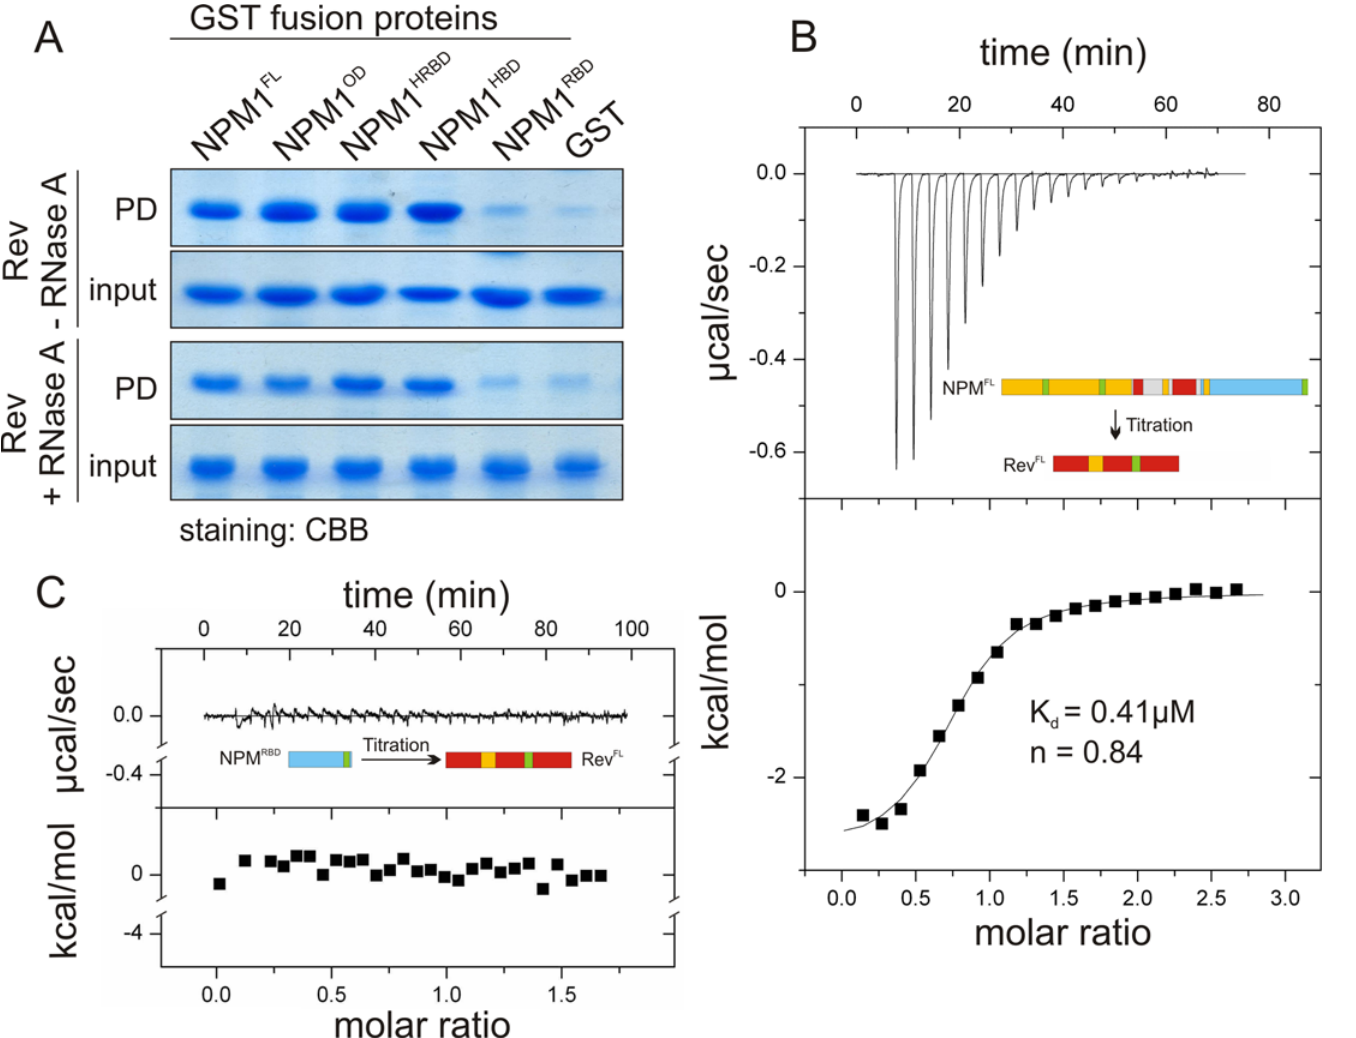
Fig 2. Direct NPM1 interaction with HIV-1 Rev. (A) Qualitative interaction analysis by GST pull-down assay and subsequent CBB staining. NPM1 FL, OD and HRBD, but not RBD, displayed a selective interaction with HIV-1 Rev (upper panel), which was also observed after an RNase A treatment (lower panel). (B) Quantitative interaction analysis by ITC. The binding parameters for the interaction between NPM1 FL and Rev were obtained using ITC. Titration of NPM1 FL (750 μ M) to Rev FL (35 μ M) showed an exothermic response (negative peaks) indicating that Rev selectively interacts with NPM1 FL . The upper graph shows calorimetric changes plotted versus the time and the lower graph represents the changes in temperature according to the molar ratio of the interacting proteins. (C) No interaction was observed in a control experiments by titrating NPM1 RBD (300 μ M) to Rev FL (30 μ M).